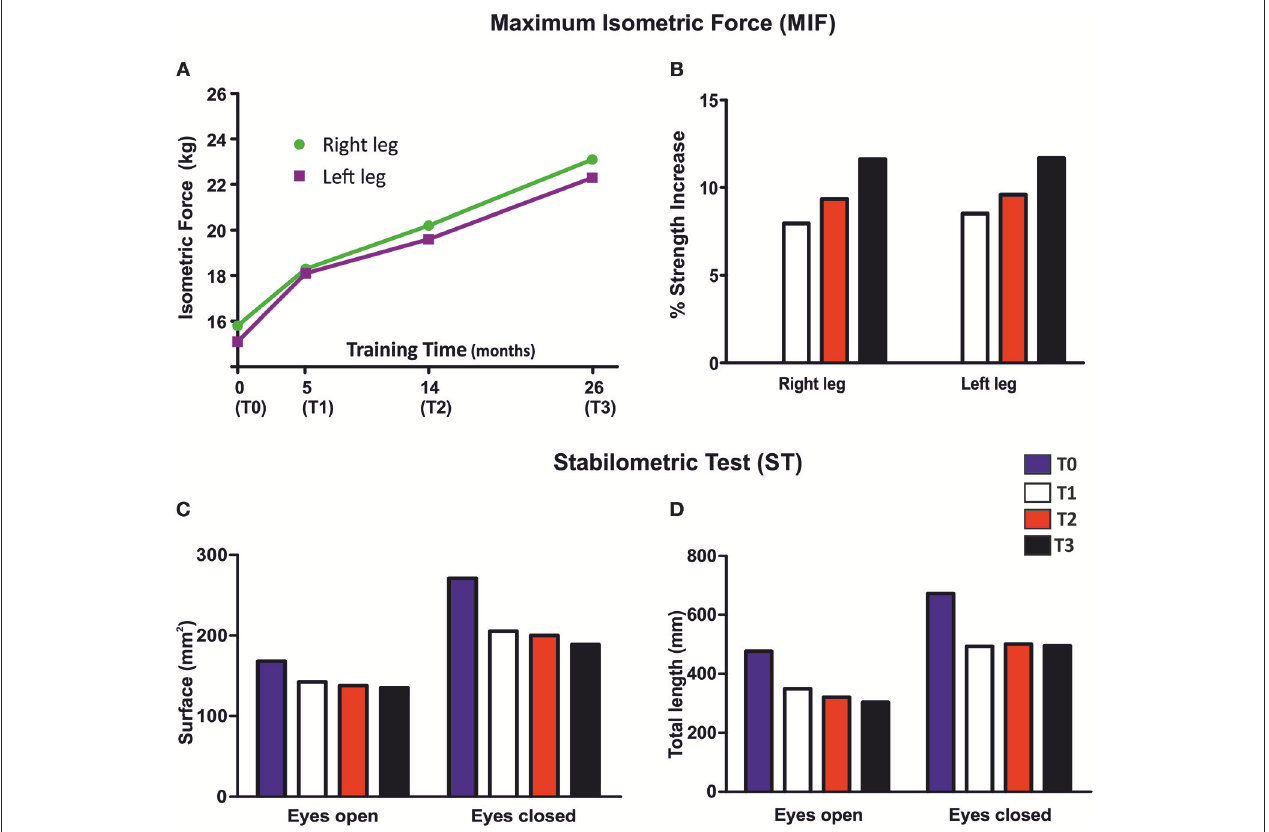
FIGURE 4 | Maximum Isometric Force (MRI) and Stabilometric Test (ST). (A) Measurements of MIF based on leg extension movement before (T0) and after 5 (T1), 14 (T2), and 26 (T3) months of FES training. (B) Variations in MIF expressed as percentage, where values from T0 were taken as 0%. (C,D) Effect of FES treatment on surface (mm 2 ) and total length (mm) in ST (52.2s), in eyes open and eyes closed configuration, before (T0), and after 5 (T1), 14 (T2), and 26 (T3) months of home-based FES